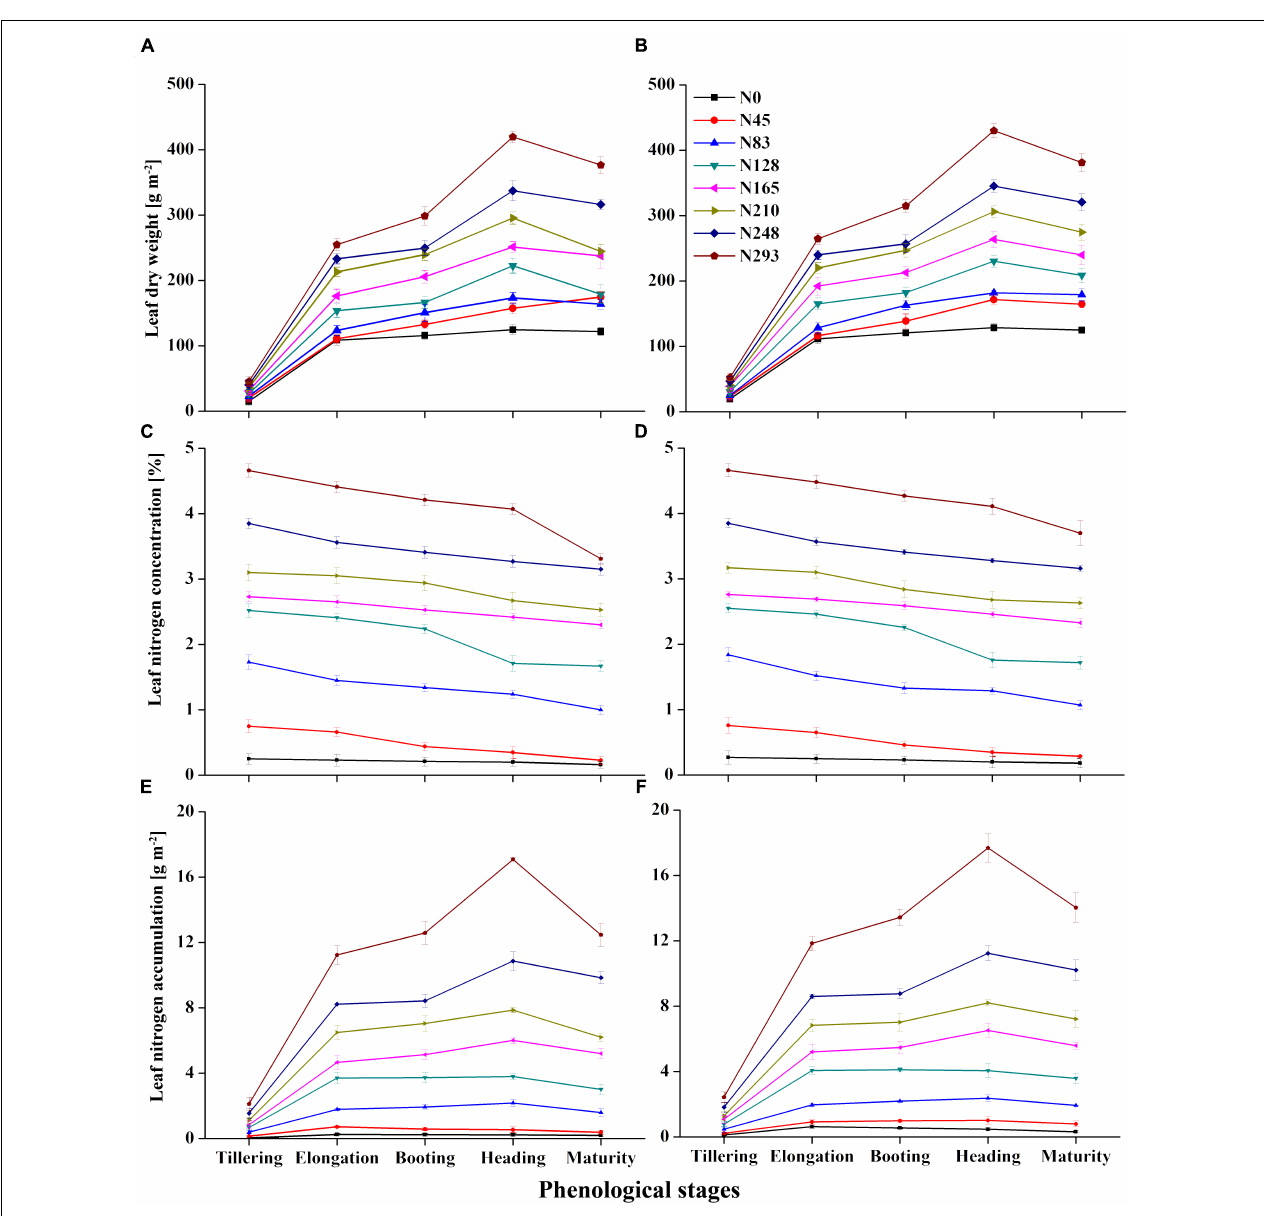
FIGURE 1 | Variation in leaf nitrogen status indicator leaf dry weight (LDW) (A,B) , leaf nitrogen concentration (C,D) and leaf nitrogen accumulation (E,F) in 2015 and 2016, respectively, over phenology of rice.